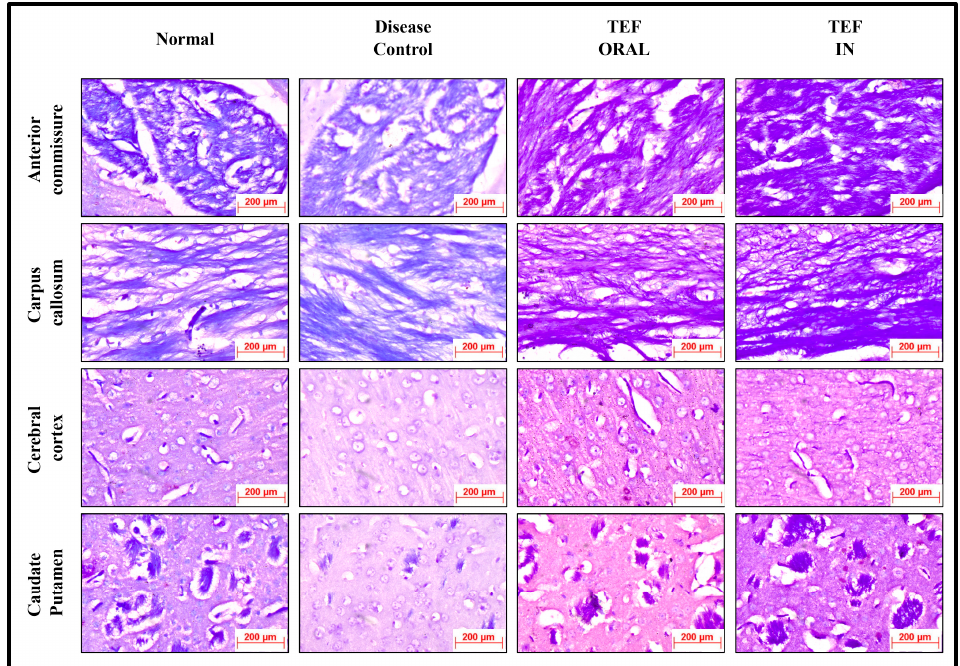
Figure 7. The LFB-stained coronal sections of the Normal, Disease Control, TEF oral, and TEF IN treatment groups (400×).